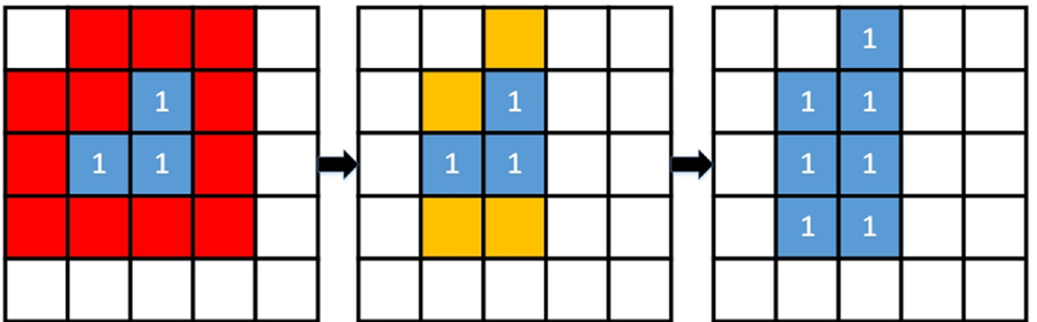
Figure 3. Schematic diagram illustrating the expanding process of growth seeds in the region growing method. Blue cells represent the initial growth seed, red cells represent the neighbouring cells, and yellow cells represent neighbouring cells that meet the joining criteria.